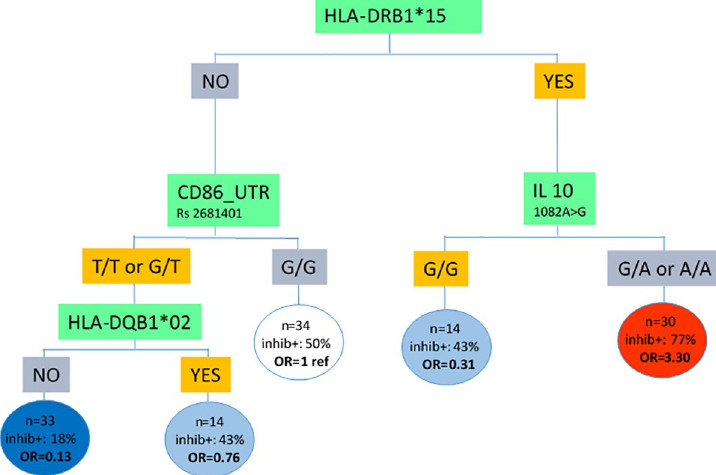
Fig 2. Optimal GPLTR tree associated with inhibitor development linearly adjusted on F8 mutation type, family history of inhibitors and type of FVIII product. n represents number of patients among 125 patients included in the